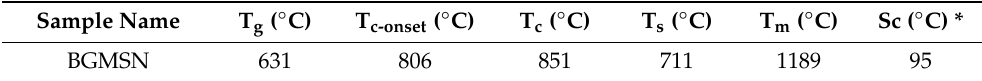
Table 2. Characteristic temperatures of BGMSN. * Sc = T c-onset − T s .